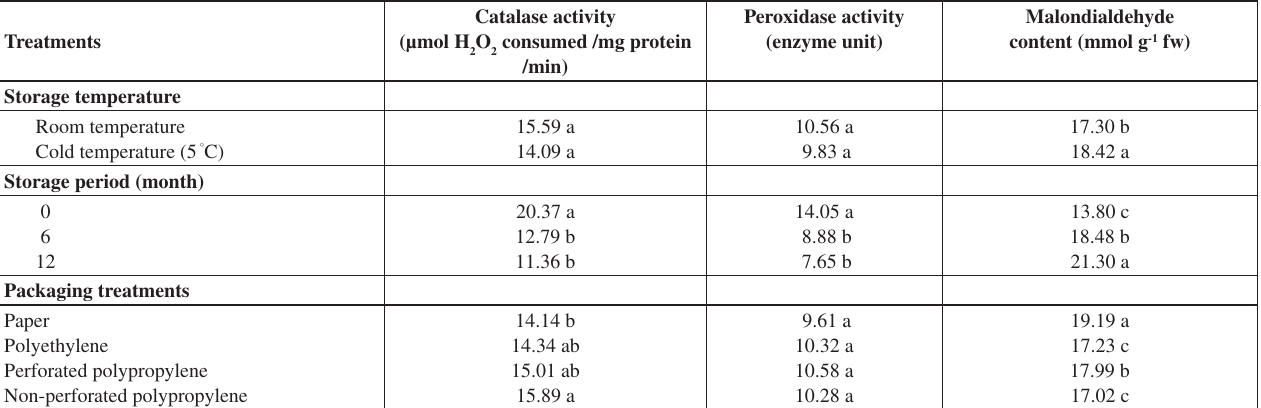
Table 2: Effect of storage temperature, storage period and packaging material on catalase and peroxidase activities and malondialdehyde